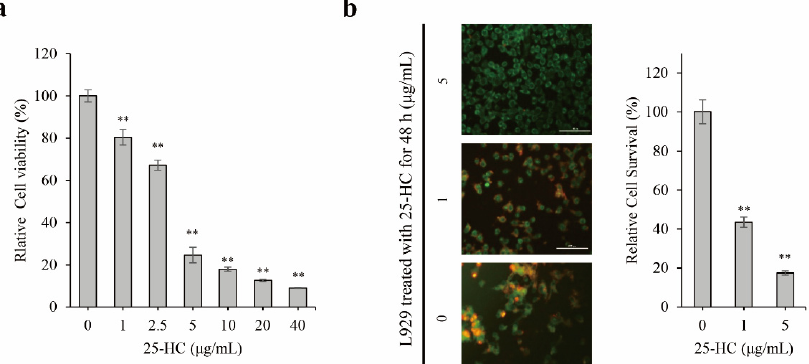
Figure 2. 25-HC induced cell death by increasing cytotoxicity and decreasing cell survival in L929 cells. ( a ) 25-HC decreased the viability of L929 cells in a dose-dependent manner. An MTT assay was performed to measure the viability of L929 cells treated with 0–40 μ g/mL 25-HC for 48 h. ( b ) 25-HC decreased the survival of L929 cells. A LIVE/DEAD™ assay was performed using Green Calcein AM to stain the live cells with green fluorescence and ethidium homodimer-1 to stain the dead cells with red fluorescence in order to assess the survival of L929 cells treated with 1 and 5 µ g/mL 25-HC for 48 h. Relative cell survival was calculated by [number of live cells/(number of live cells + number of dead cells) × 100] and was presented as histogram. Results are mean ± SD of three independent experiments ( n = 3), ** p < 0.01.